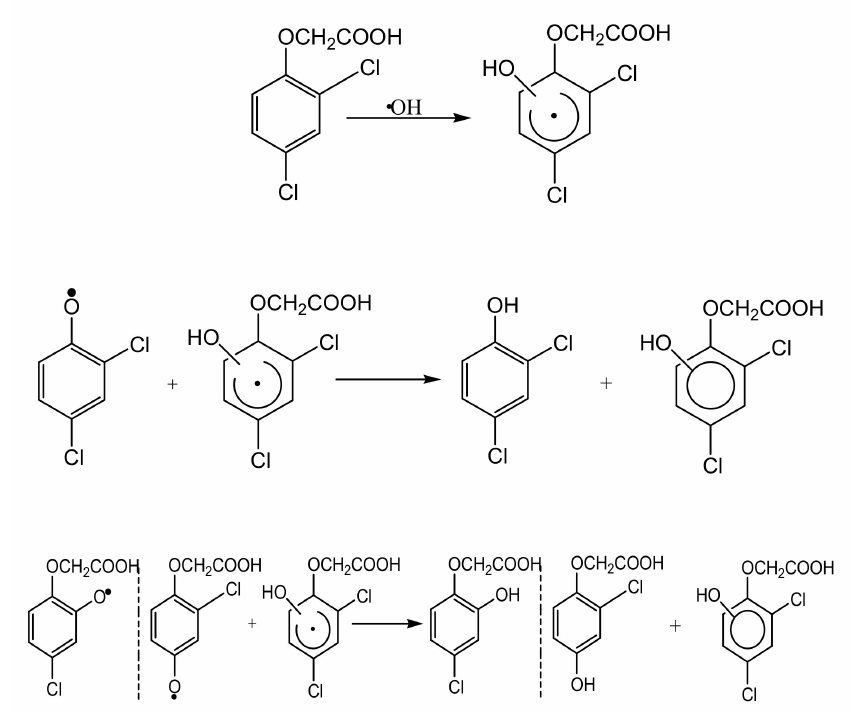
Scheme 5. Mechanism for formation of hydroxylated 2,4-Ds, 2,4-dichlorophenol and chlorohydrox- yphenoxyacetic acid.